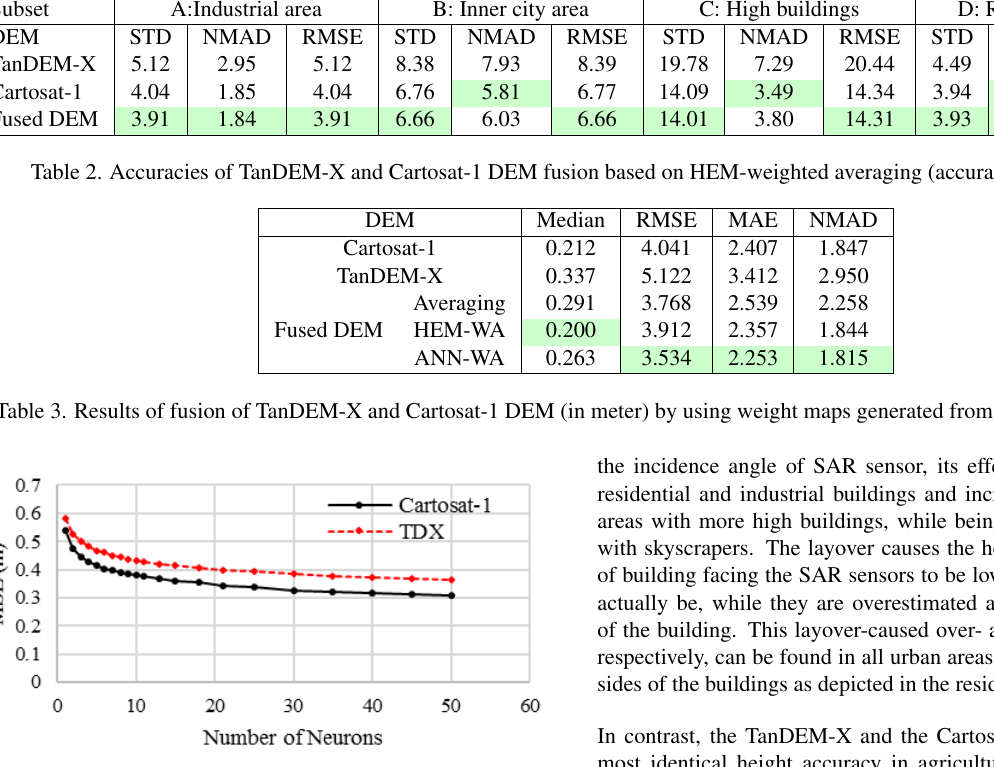
wise weighted averaging algorithm using the obtained height